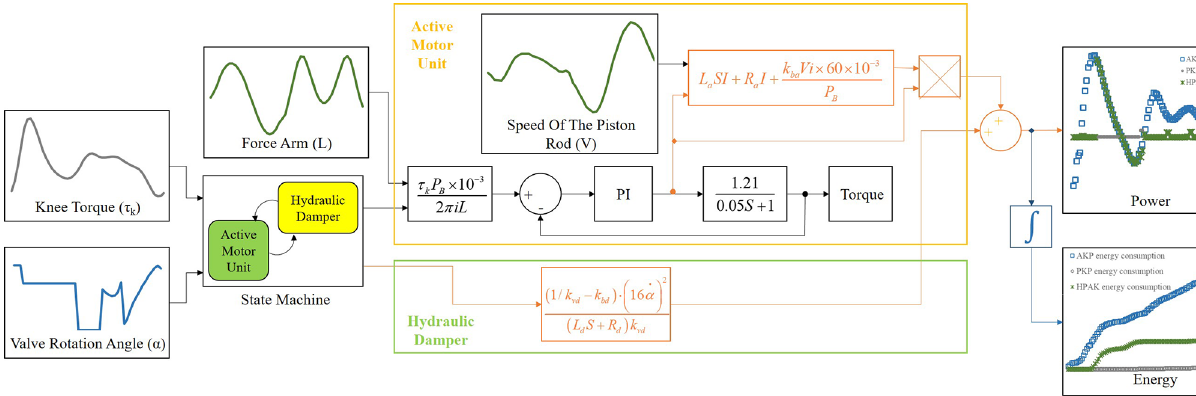
Figure 12. Block diagram of energy consumption model.